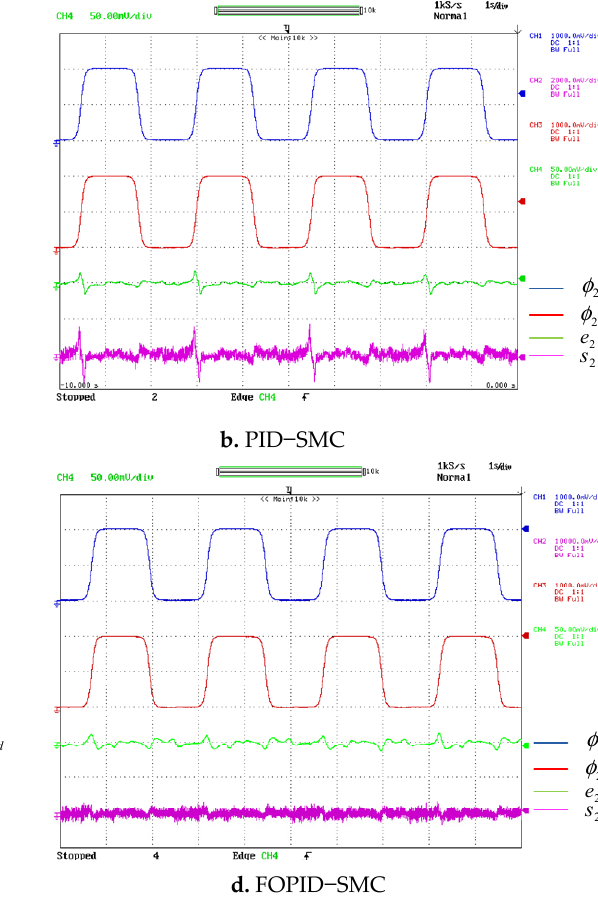
Figure 13. Trajectory tracking of the 3DOF surgical manipulator for Joint1.